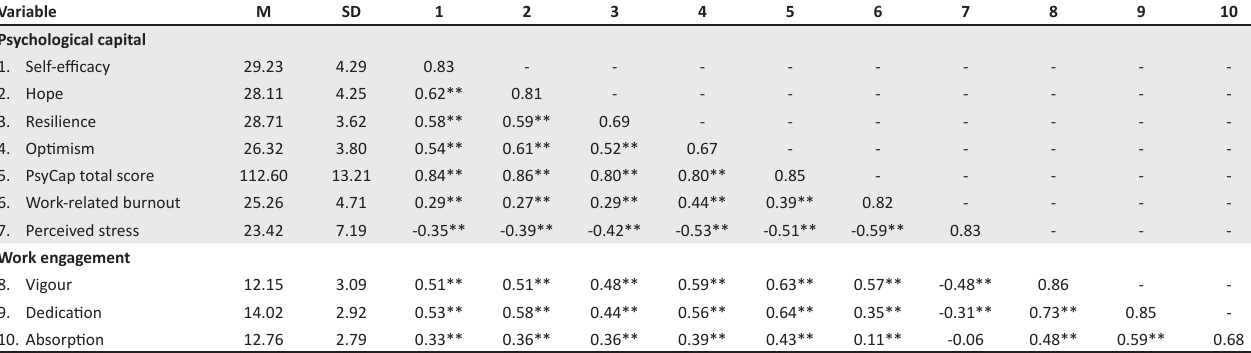
TABLE 1: Descriptive statistics: Means, standard deviations, reliabilities, and correlations for study variables.